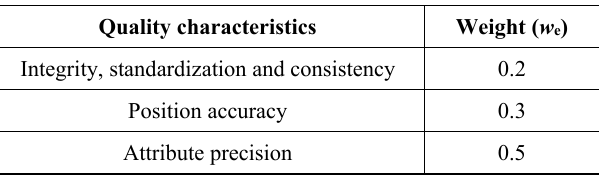
Table 2. Weight of quality characteristics